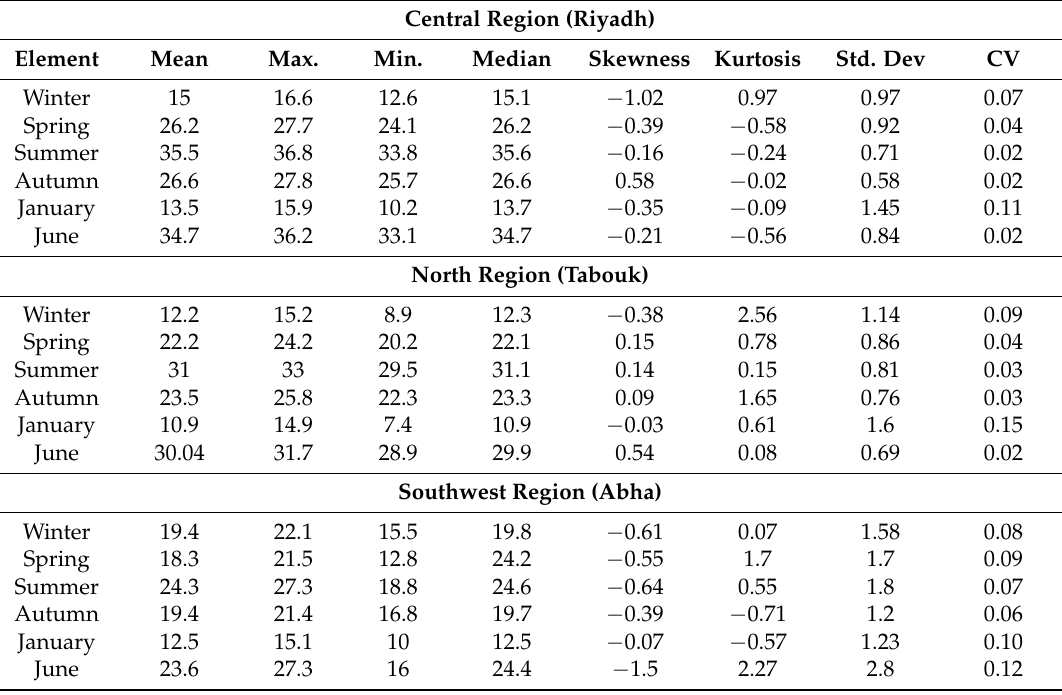
Table 1. Seasonal variability of mean temperature in the central (Riyadh), north (Tabouk) and southwest (Abha) regions of Saudi Arabia. Central Region